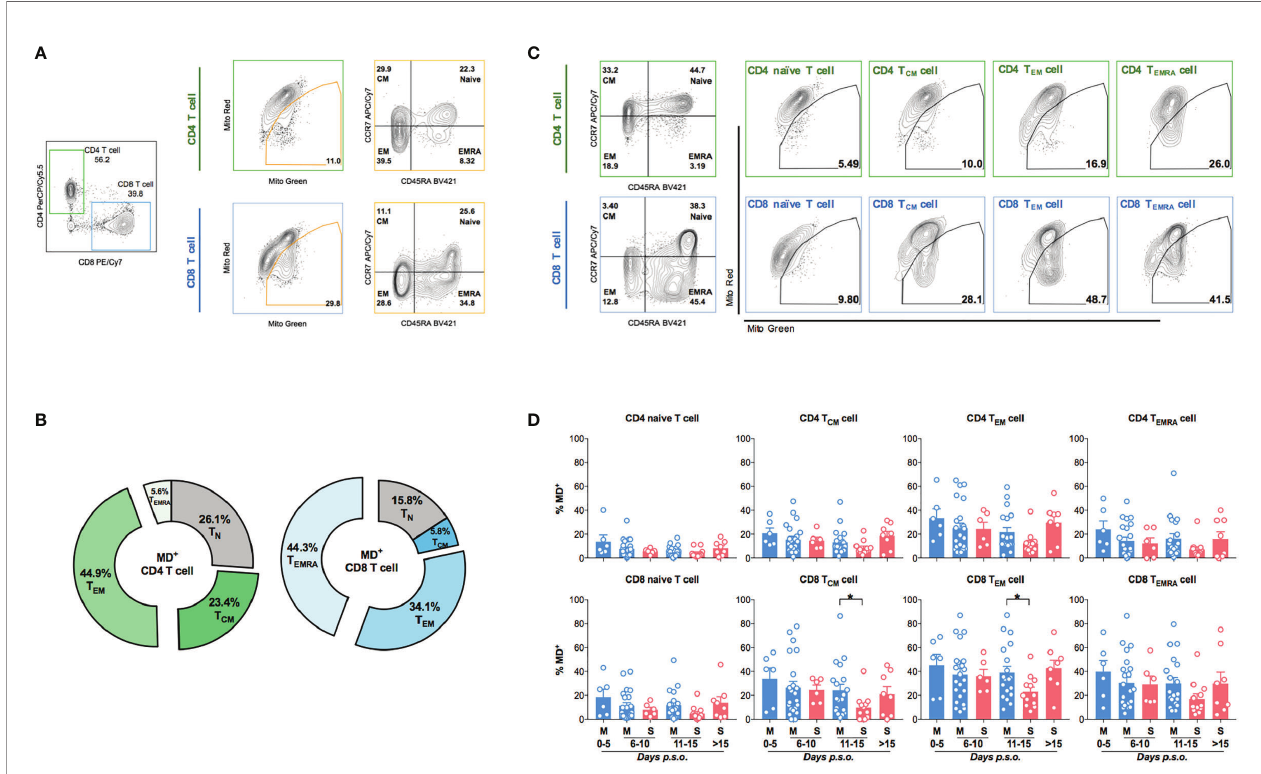
FIGURE 2 | Higher percentage of MD + cells is found in memory CD8 T cell from mild patients than severe patients at 11-15 days p.s.o. during SARS-CoV-2 infection. Eighty-eight SARS-CoV-2 acute patients (APs) were collected for data analysis on T-cell subsets among cells with mitochondrial dysfunction (MD + ) using fl ow cytometry in at least three independent experiments. (A) Representative plots showed the gating strategy on Naive T (CD45RA + CCR7 + ), central memory T (T CD45RA - CCR7 + ), effector memory T (T EM , CD45RA - CCR7 - ), and effector memory T-cell re-expressing CD45RA (T EMRA , CD45RA + CCR7 - ) from MD + CD4 or CD8 T cells. (B) The average proportions of different T-cell subsets in MD + CD4 T-cell and CD8 T-cell subsets were calculated and displayed (number represents mean) in pie charts. Seventy-three SARS-CoV-2 APs [47 mild (M) and 26 severe (S) ones; only one mild AP on Day 16 post symptoms onset (p.s.o.) was excluded for statistical analysis] were collected for data analysis on MD + cells in various T-cell subsets using fl ow cytometry in at least three independent experiments. (C) Representative plots showed the gating strategy on MD + cells from Naive T, T CM , T EM , and T EMRA subsets from CD4 or CD8 T cells. (D) The percentages of MD + cells in Naive T, T CM , T EM , and T EMRA subsets from CD4 T cells and CD8 T cells along disease development were compared between mild and severe APs. Data represent mean ± SEM. Statistics were calculated based on unpaired Student ’ s t-test. * p <